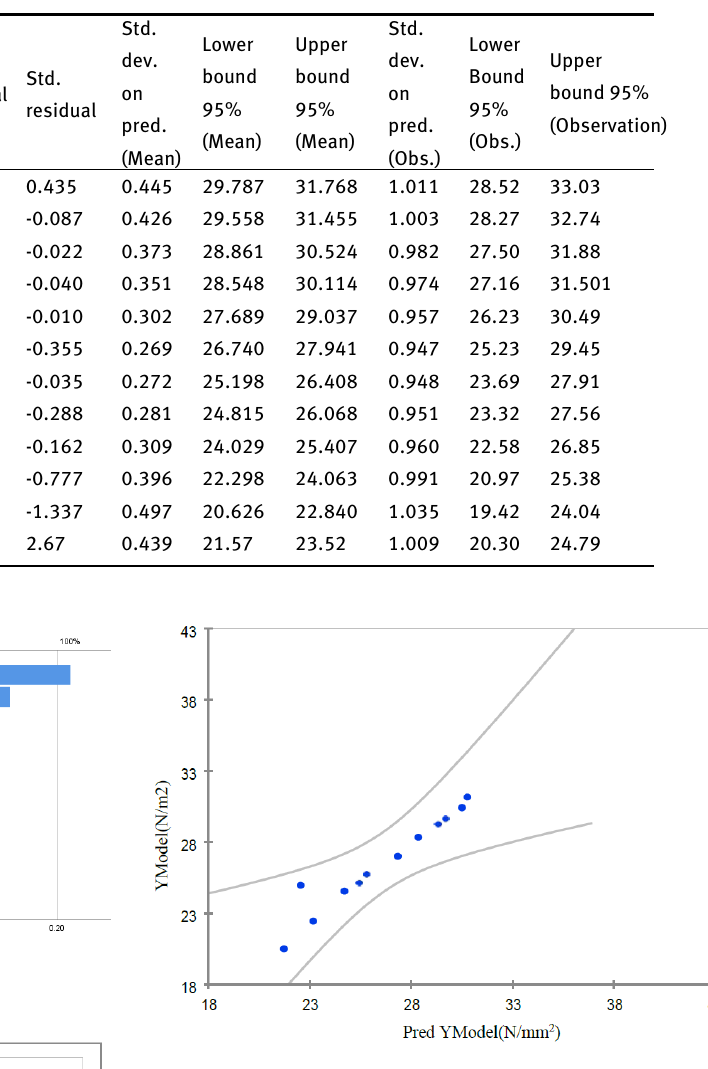
Figure 10: Pred (Y Model (N/m 2 )/Y Model (N/m 2 )